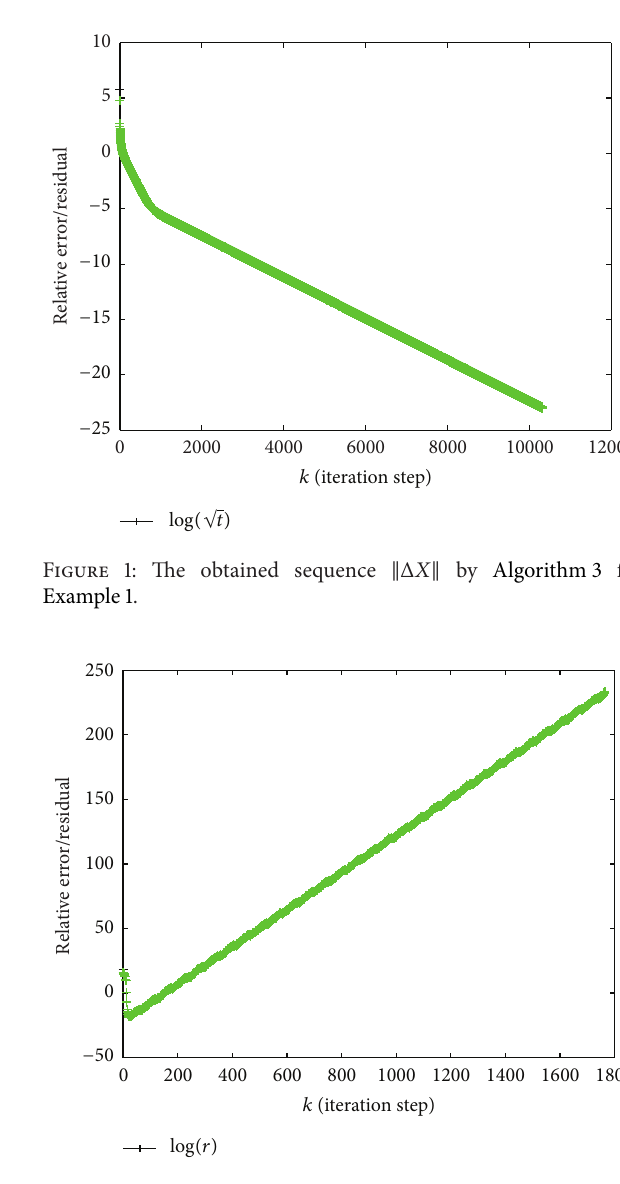
Figure 2: The relative error of the solution and the residual by the algorithm of [32] for Example